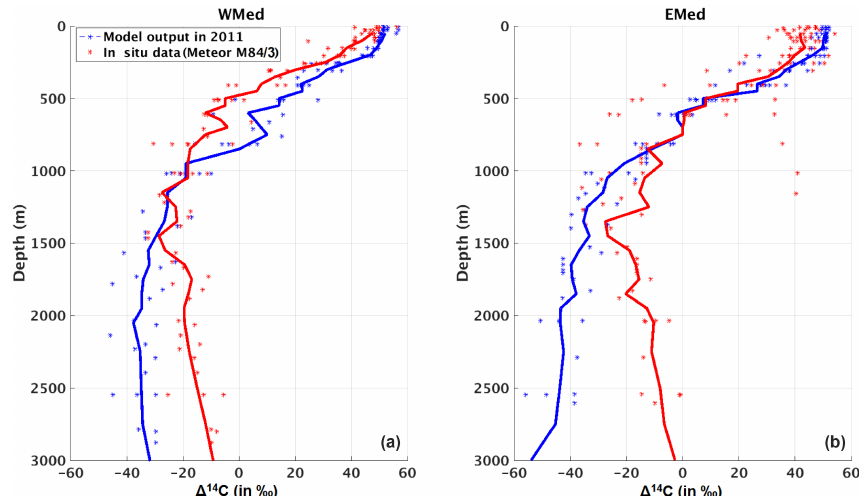
Figure 8. Comparison of average vertical profiles of (cid:49) 14 C in the WMed (left) and in the EMed (right). Model results are in blue; red indicates the in situ